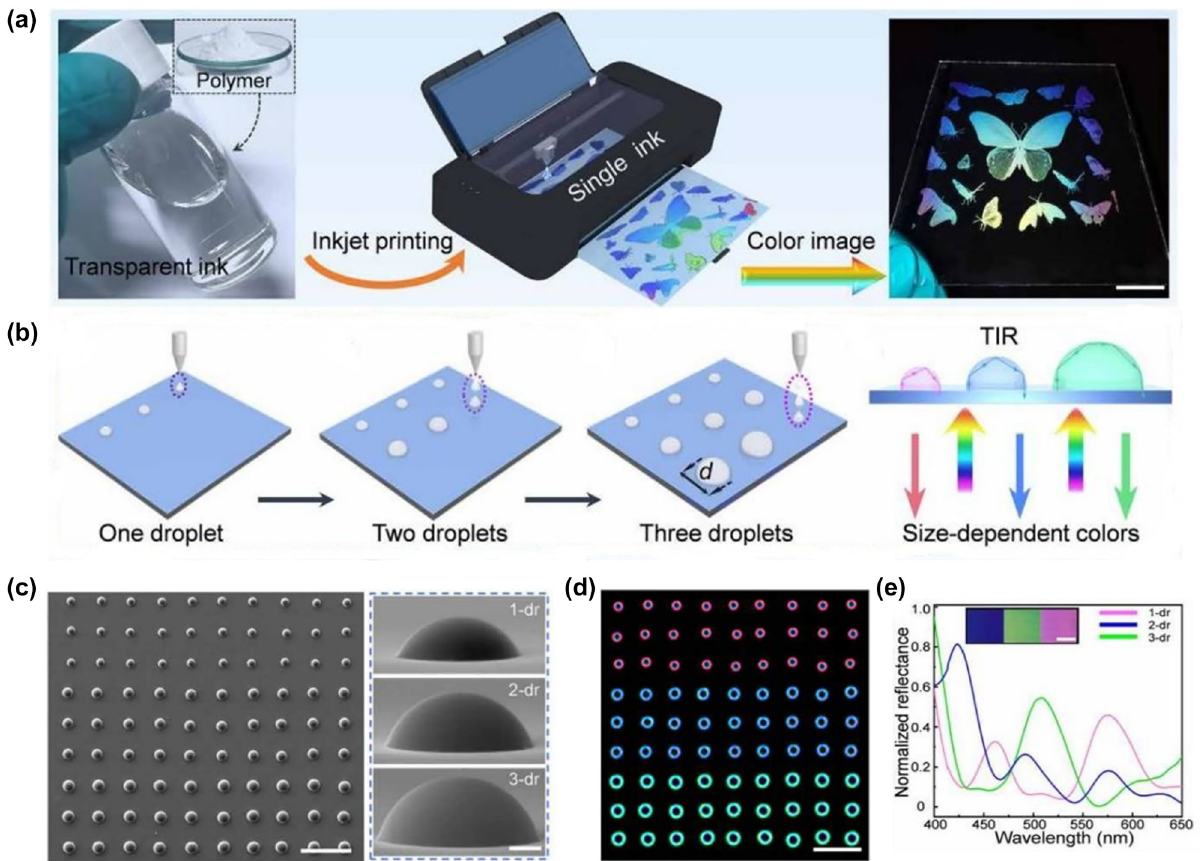
Figure 26: Digital inkjet printing for fabricating subwavelength nanostructure array based structural colors. (a) The process of structural-color printing with a single transparent polymer ink. (b) Schematic illustration of the droplet-by droplet printing process. (c) Top-view (left) and cross-sectional (right) SEM images of printed microdomes with different diameters. (d) Dark-field optical micrographs of the microdomes observed from the bare-glass side. (e) Reflection spectra of the printed structural-color panel at the macroscale. Inset shows the associated optical images.